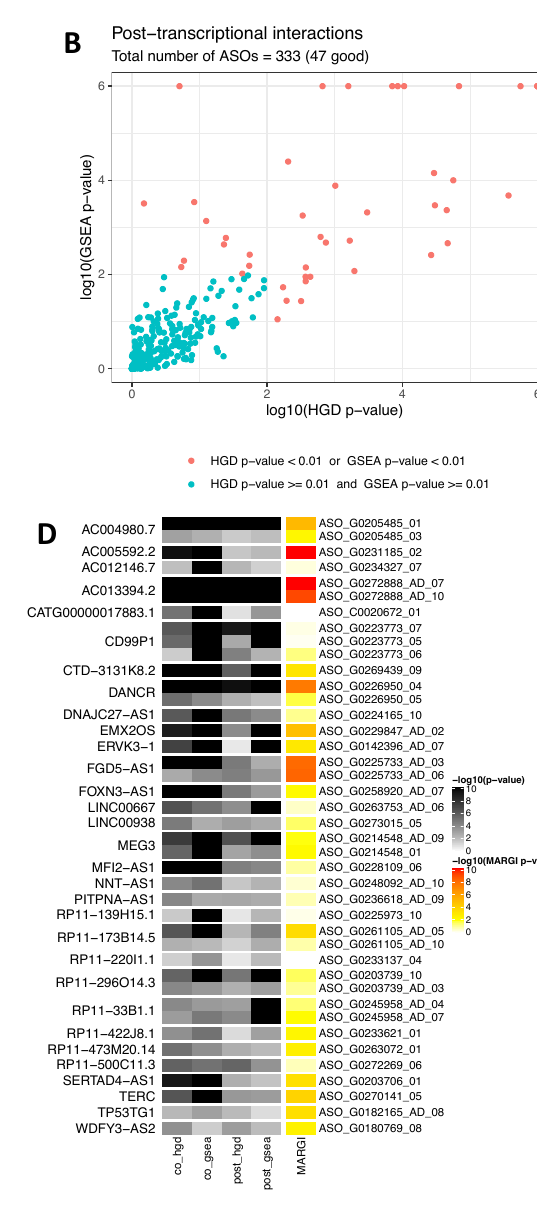
Figure 2. Enrichment of the lncRNA hybridization targets predicted by ASSA among differentially expressed genes identified in the FANTOM6 ASO knockdown experiments in two modes. ( A , B ) ASSA was applied to the differentially expressed and background transcripts assuming co-transcriptional or post-transcriptional lncRNA:RNA interaction mode. The-log of enrichment p -values were computed 10 using the hypergeometric (HGD) and GSEA tests. Knockdowns with either p -value < 0.01 are marked by the red color. There were 98 and 47 such ASOs for the co- and post-transcriptional modes, respectively. ( C ) The majority (41 out of the 47) of the ASOs with significant p -values in the post-transcriptional mode also had significant p -values in the co-transcriptional mode. ( D ) The heatmap showing four p -values for the 41 ASOs that produced strong p -values in both the co- and the post-transcriptional modes. The 41 ASO ids are on the right side and the corresponding 31 lncRNA gene names are on the left side of the heatmap. The p -values of the co-occurrence with the iMARGI peaks are shown on the